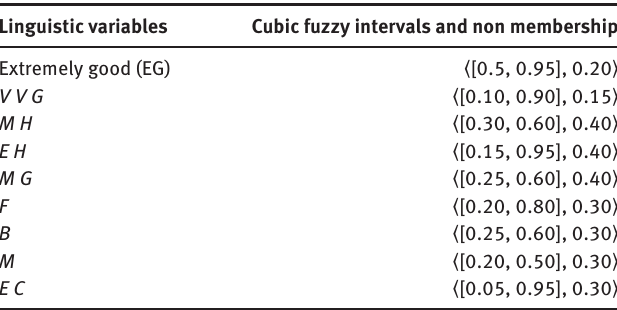
Table 1: Linguistic Variables for the Rating of Candidates. Linguistic variables Cubic fuzzy intervals and non